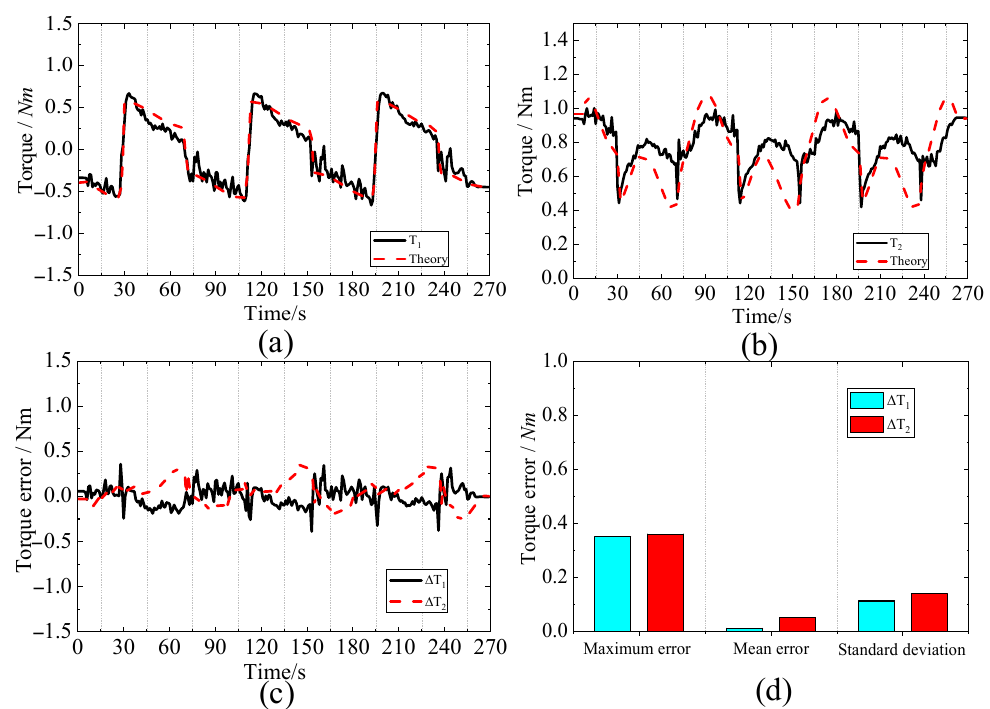
Figure 13. Comparative analysis of theoretical and experimental data of equivalent joint torques. ( a ) Theoretical and experimental data of T 1 under vertical sinusoidal trajectory. ( b ) Theoretical and experimental data of T 2 under horizontal sinusoidal trajectory. ( c ) T 1 and T 2 errors. ( d ) Analysis of the error characteristics of T 1 and T 2 .